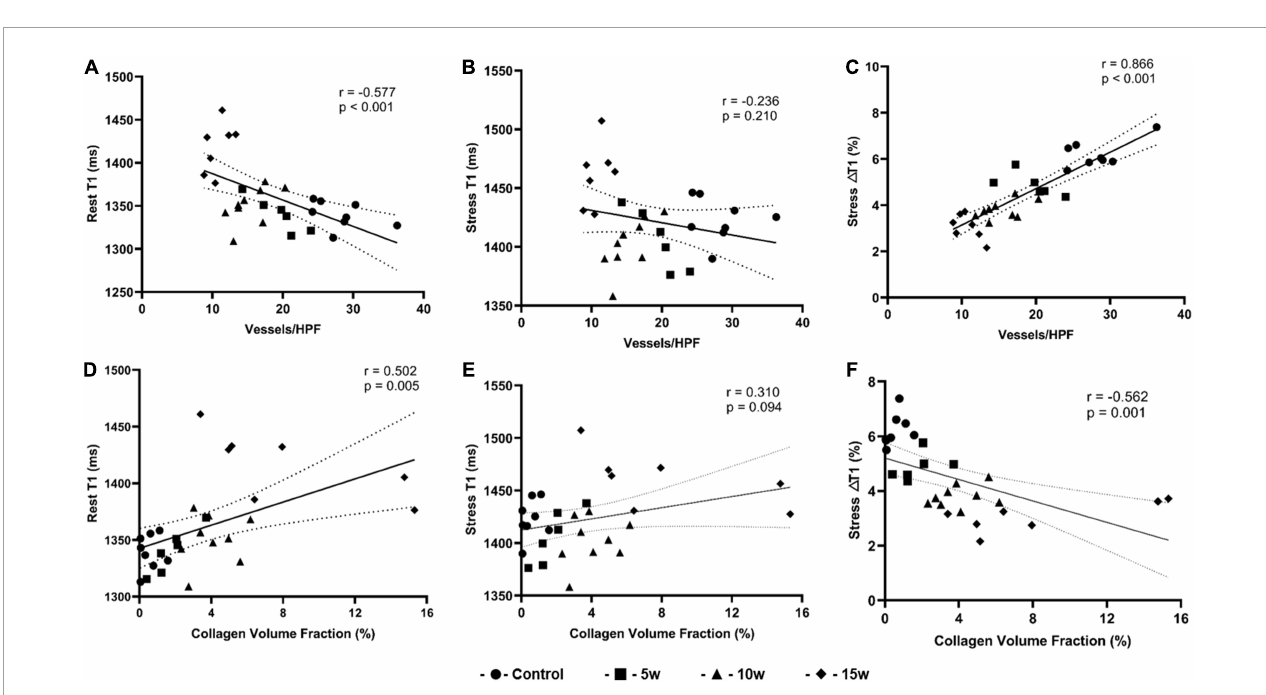
FIGURE6 Graphs show correlation between histopathologic findings and imaging parameters derived from T1 mapping for all four groups ( n = 30). (A) Rest T1 values and MVD correlation; (B) Stress T1 values and MVD correlation; (C) Stress T1 response and MVD correlation; (D) Rest T1 values and CVF correlation; (E) Stress T1 values and CVF correlation; (F) Stress T1 response and CVF correlation. CVF: collagen volume fraction; MVD: microvascular